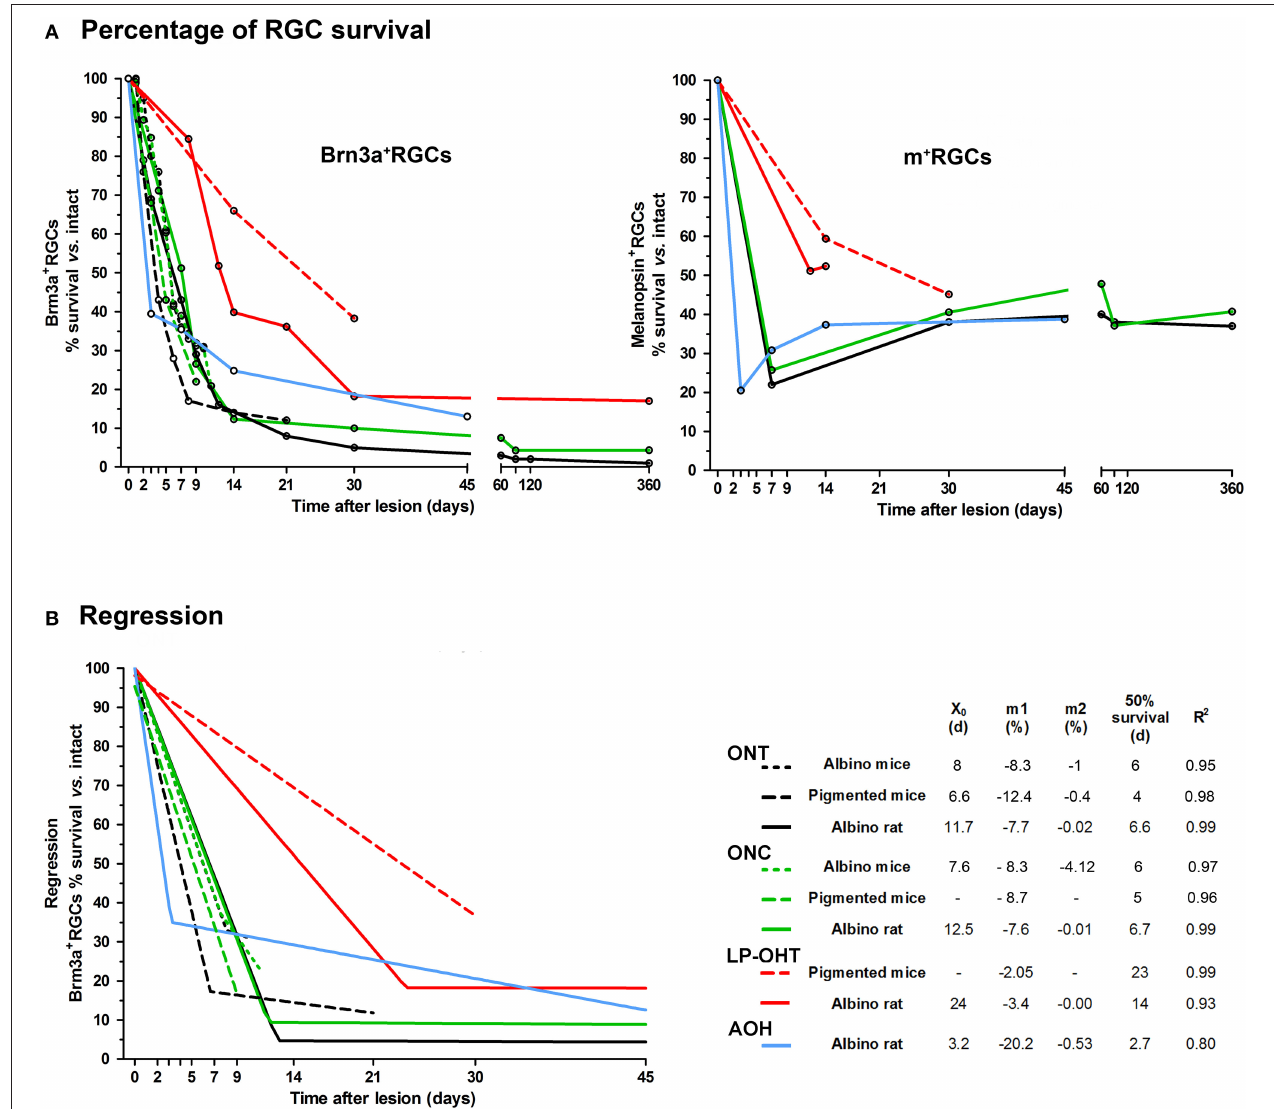
FIGURE 1 | Temporal course of RGC loss after axotomy or ocular hypertension. (A) Graph showing the loss of Brn3a + RGCs (left) and melanopsin + RGCs (right) as percent of naive retinas vs. time post-lesion (days) after ONC, ONT, LP-OHT, or AOH in rats and mice. The open circles mark the time points of retinal analysis. Legend as in (B). (B) Graph showing the regression analysis of the loss of Brn3a + RGCs (percent of naive retinas, data in (A) vs. time post-lesion (days) after ONC, ONT, LP-OHT, or AOH in rats and mice. All courses adjust to either a segmental linear or to a linear regression. For ONT, ONC, and LP-OHT in rat the analysis was done with data points > 45 days (see A ) but the regression graph was cropped at 45 days for clarity. ONC, optic nerve crush at 0.5 mm from the optic head for mice, and 2 mm for rat. ONT: optic nerve transection at 0.5 mm from the optic nerve in both species. LP-OHT: ocular hypertension induced by laser-photocoagulation, in this model the increase of intra-ocular pressure lasts a week and rises on average up to 40 mmHg. AOH: acute ocular hypertension, induced by cannulating the anterior chamber, in this model the intra-ocular pressure was elevated to 76 mmHg for 75 min. X 0 indicates the day when the first linear phase of RGC loss changes to a second, slower, one. m1 and m2 are the slopes of the first and second linear phases, respectively and show the daily loss of RGCs (in percent). Fifty percent survival is the time (days) when, according to the mathematical analysis, half of the RGCs are lost. R 2 is the fitness of the regression. Albino mice: Swiss. Pigmented mice: C57/BL6. Albino rat: Sprague Dawley. These graphs were constructed using data from Salinas-Navarro et al. (2009c, 2010), Nadal-Nicolás et al. (2009, 2015a), Galindo-Romero et al. (2011, 2013b), Ortín-Martínez et al. (2015), Rovere et al. (2015, 2016a), Valiente-Soriano et al. (2015a,b), and Sánchez-Migallón et al. (2016).